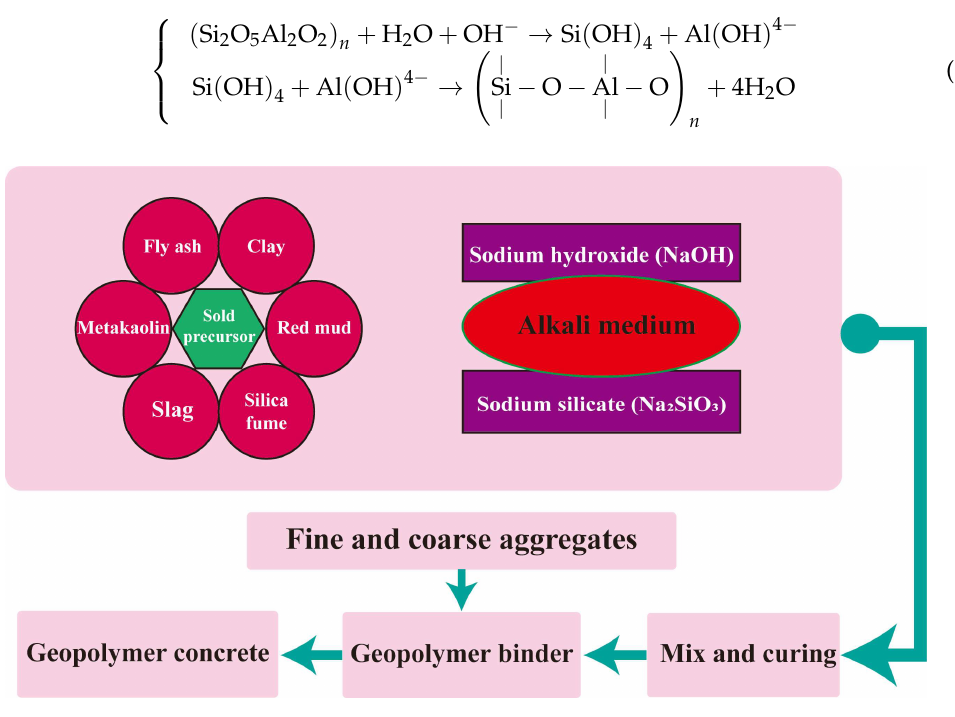
Figure 4. The preparation process of geopolymer concrete. The comparison of chemical composition between the geopolymer used currently and ordinary Portland cement is shown in Table 1. Table 1. Chemical composition of ordinary Portland cement and geopolymer (%).